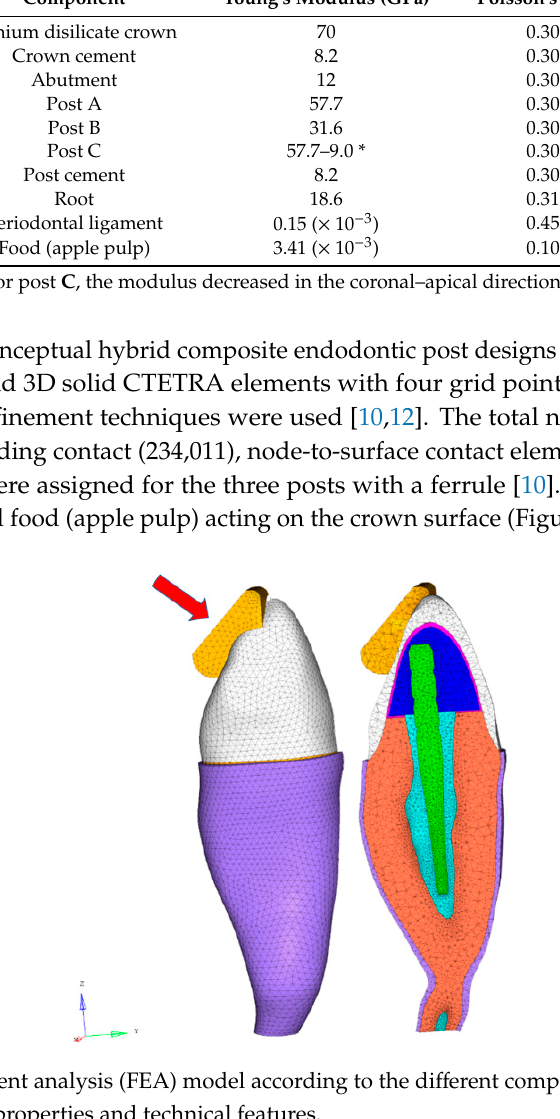
Table 1. Young’s moduli and Poisson’s ratios for di ff erent model components.